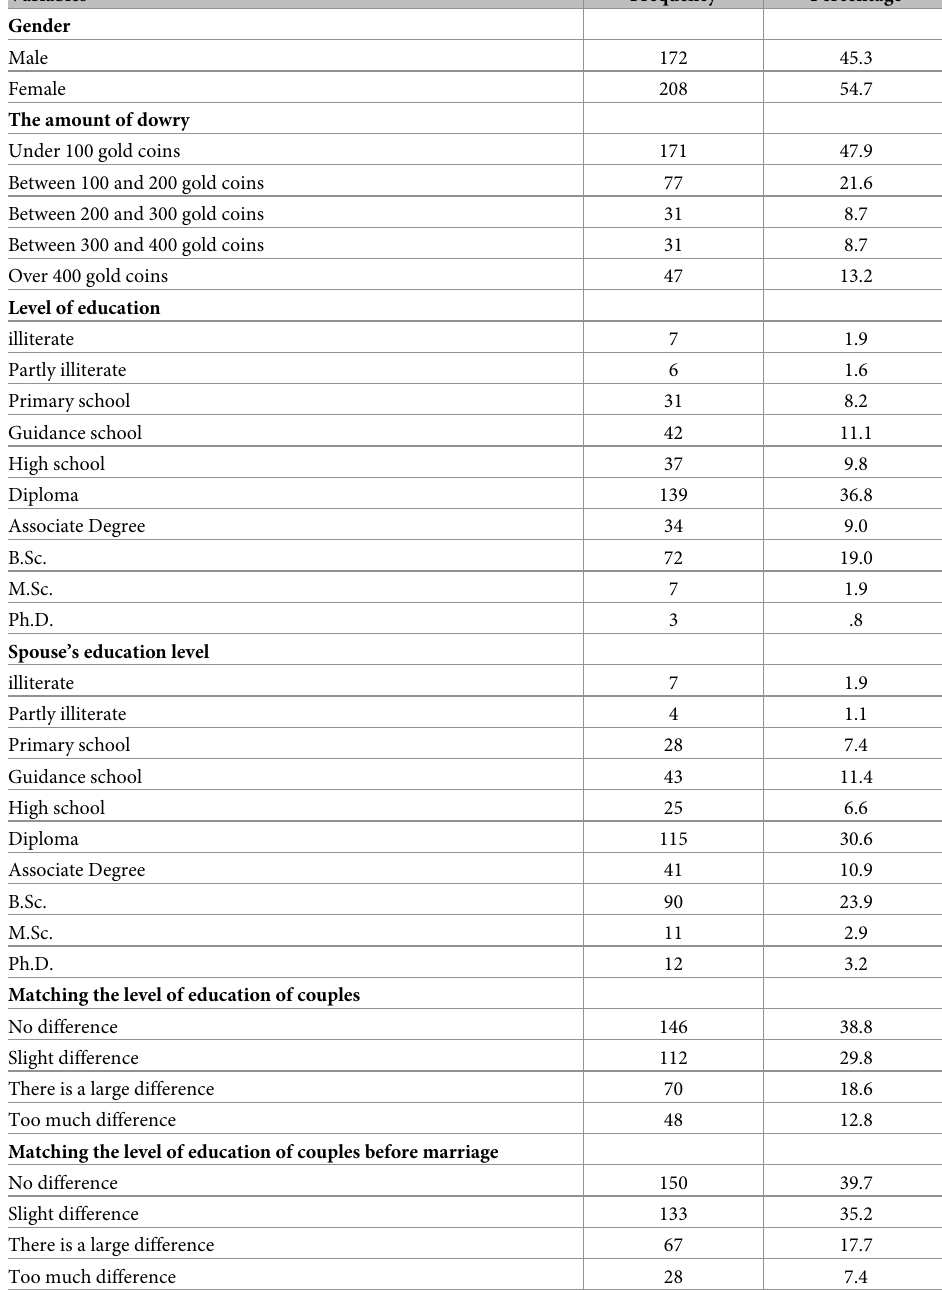
Table 1. Demographic profile of study